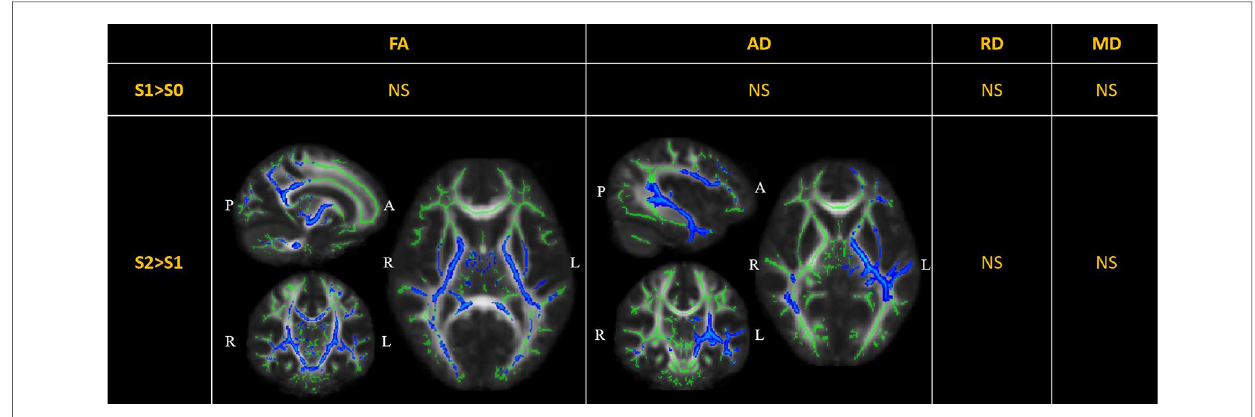
FIGURE 2 Perioperative changes in diffusion tensor imaging (DTI) metrics across S0, S1, and S2. In S2> S1, the FA of white matter (WM) tracts, including the bilateral corticospinal tracts (MNI [ (cid:1) 15 (cid:1) 11 (cid:1) 5], peak t value ¼ 4 : 53), bilateral cingula (cingulate gyri) (MNI [15 (cid:1) 8 35], peak t value ¼ 3 : 22), bilateral internal capsules (MNI [ (cid:1) 16 (cid:1) 10 1], peak t value ¼ 4 : 25), bilateral external capsules (MNI [ (cid:1) 29 10 (cid:1) 1], peak t value ¼ 2 : 58), and left superior longitudinal fasciculus (MNI [ (cid:1) 40 (cid:1) 17 28], peak t value ¼ 4 : 08), was signi fi cantly reduced; the AD was signi fi cantly reduced in the left superior-frontal blade (MNI [ (cid:1) 42 (cid:1) 7 (cid:1) 14], peak t value ¼ 3 : 40), left parieto-temporal blade (MNI [ (cid:1) 42 (cid:1) 28 -5], peak t value ¼ 4 : 48), left internal capsule (MNI [ (cid:1) 21 (cid:1) 17 (cid:1) 3], peak t value ¼ 4 : 52), left external capsule (MNI [ (cid:1) 31 7 (cid:1) 3], peak t value ¼ 2 : 91), and left corticospinal tract (MNI [ (cid:1) 18 (cid:1) 17 (cid:1) 5], peak t value ¼ 3 : 27). The signi fi cant results (TFCE- p , 0 : 05) are displayed as a blue color tract, using the “ tbss_ fi ll ” script of FSL. The green tract represents the WM tract mask image used during randomized statistics. S0, before the surgery; S1, in the fi rst month after the surgery; S2, 3 – 6 months after the surgery. FA, fractional anisotropy; AD, axial diffusivity; RD, radial diffusivity; MD, mean diffusivity; NS not signi fi cant.